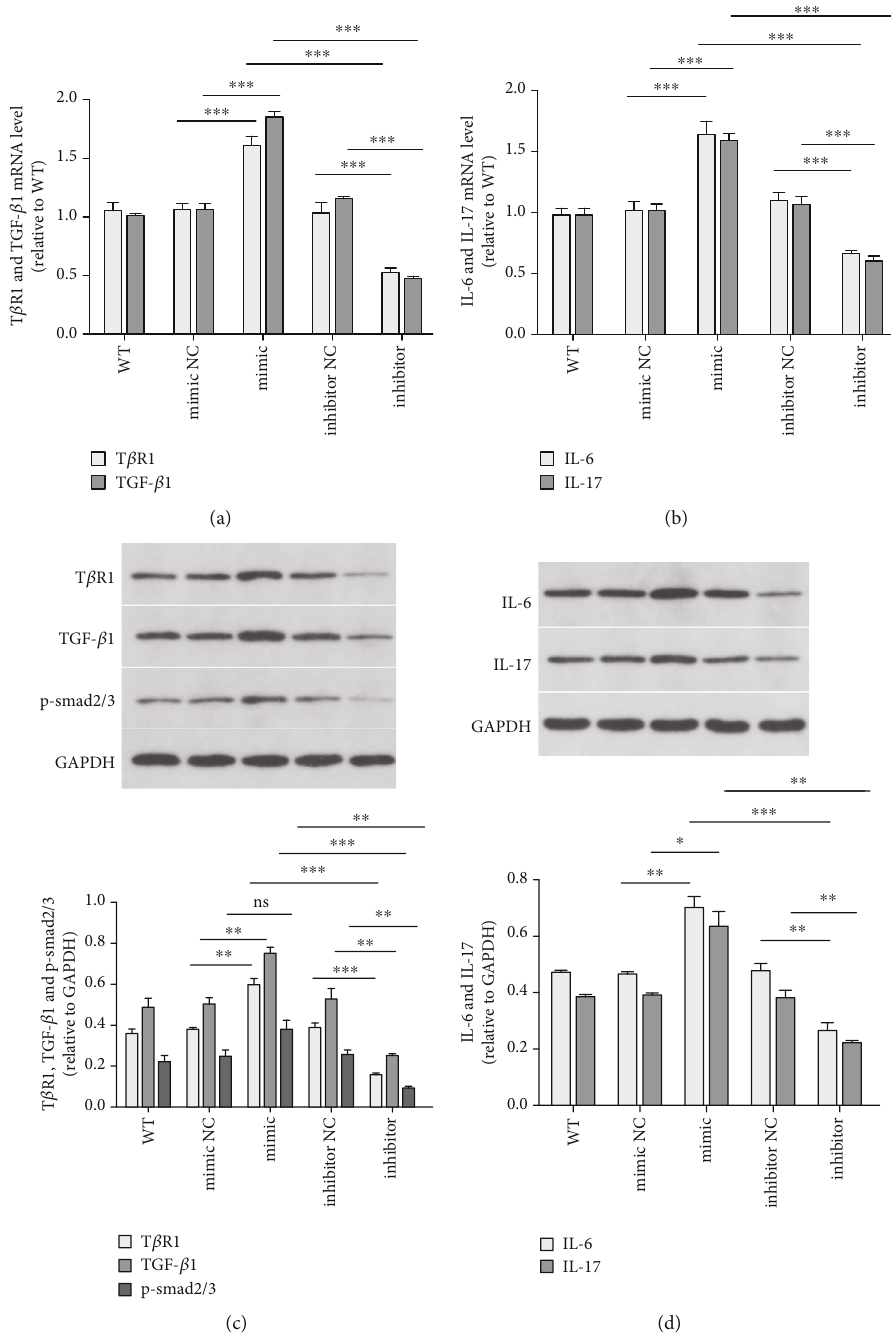
Figure 6: miR-34a promoted EMT and fi brosis of HIBEC through the TGF- β 1/smad pathway and miR-34 upregulated in fl ammatory factors. (a) T β R1 and TGF- β 1 mRNA levels (for T β R1, miR-34a mimics vs. NC, P < 0 : 0001 ∗∗∗ ; miR-34a mimics vs. inhibitor, P < 0 : 0001 ∗∗∗ ; and miR-34a inhibitor vs. NC, P < 0 : 0001 ∗∗∗ ; for TGF- β 1, miR-34a mimics vs. NC, P < 0 : 0001 ∗∗∗ ; miR-34a mimics vs. inhibitor, P < 0 : 0001 ∗∗∗ ; and miR-34a inhibitor vs. NC, P < 0 : 0001 ∗∗∗ ). (b) IL-6 and IL-17 mRNA levels (for IL-6, miR-34a mimics vs. NC, P = 0 : 0002 ∗∗∗ ; miR-34a mimics vs. inhibitor, P < 0 : 0001 ∗∗∗ ; and miR-34a inhibitor vs. NC, P < 0 : 0001 ∗∗∗ ; for IL-17, miR-34a mimics vs. NC, P = 0 : 0002 ∗∗∗ , miR-34a mimics vs. inhibitor, P < 0 : 0001 ∗∗∗ ; and miR-34a inhibitor vs. inhibitor-NC, P < 0 : 0001 ∗∗∗ ). (c) Relative T β R1, TGF- β 1, and p-smad2/3 protein expressions (for T β R1, miR-34a mimics vs. NC, P = 0 : 0013 ∗∗ ; miR-34a mimics vs. inhibitor, P < 0 : 0001 ∗∗∗ ; and miR-34a inhibitor vs. NC, P = 0 : 0006 ∗∗∗ ; for TGF- β 1, miR-34a mimics vs. NC, P = 0 : 0039 ∗∗ ; miR-34a mimics vs. inhibitor, P < 0 : 0001 ∗∗∗ ; and miR-34a inhibitor vs. NC, P = 0 : 0090 ∗∗ ; for p-smad2/3, miR-34a mimics vs. NC, P = 0 : 0679 , ns; miR-34a mimics vs. inhibitor, P = 0 : 0027 ∗∗ , and miR-34a inhibitor vs. NC, P = 0 : 0041 ∗∗ ). (d) Relative IL-6 and IL-17 protein expressions (for IL-6, miR-34a mimics vs. NC, P = 0 : 004 ∗∗ ; miR-34a mimics vs. inhibitor, P = 0 : 0008 ∗∗∗ ; and miR-34a inhibitor vs. NC, P = 0 : 0047 ∗∗ ; for IL-17, miR-34a mimics vs. NC, P = 0 : 0186 ∗ ; miR-34a mimics vs. inhibitor, P = 0 : 0028 ∗∗ ; and miR-34a inhibitor vs. NC, P = 0 : 0062 ∗∗